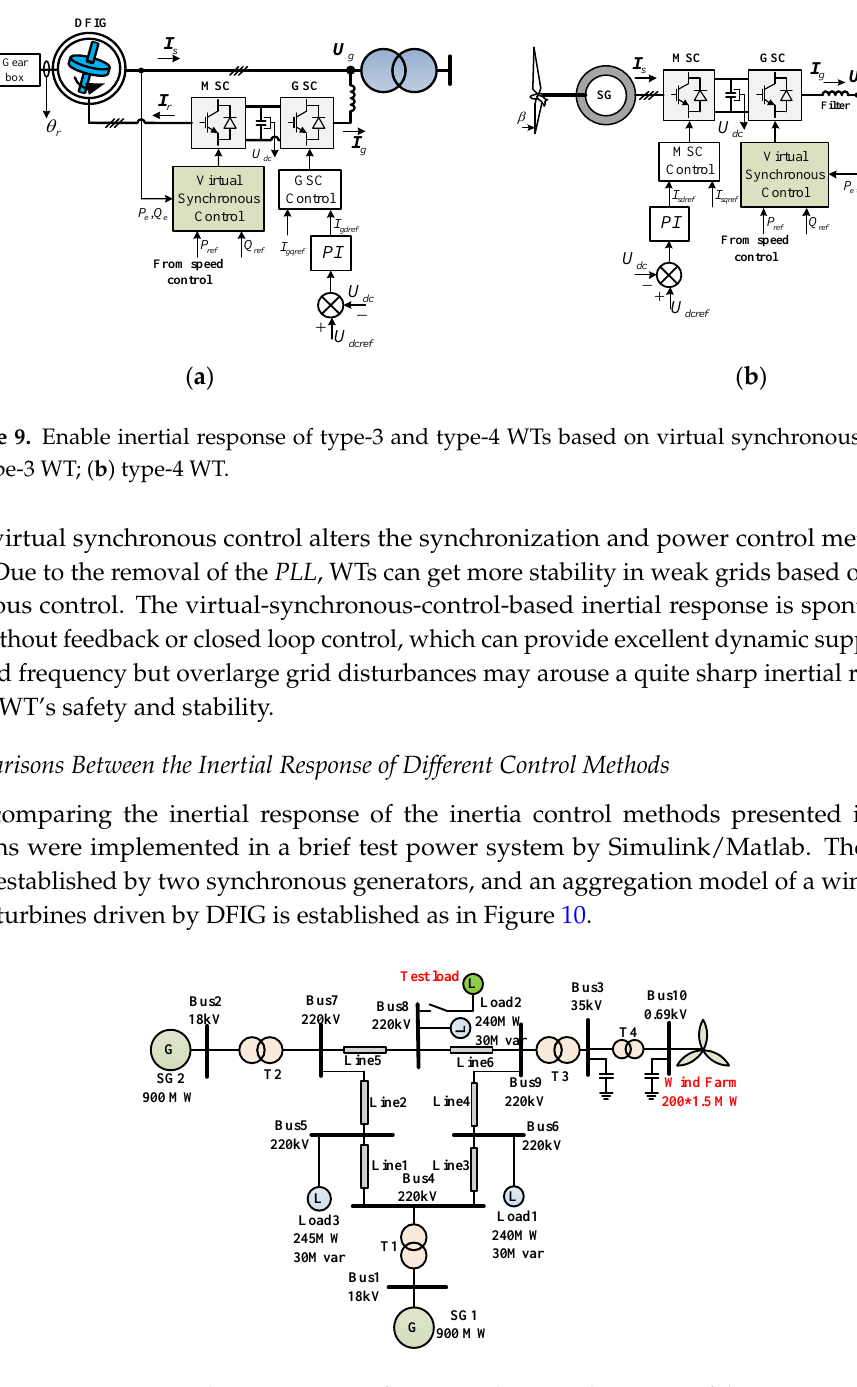
Figure 10. The power system for testing the inertial response of the WT.